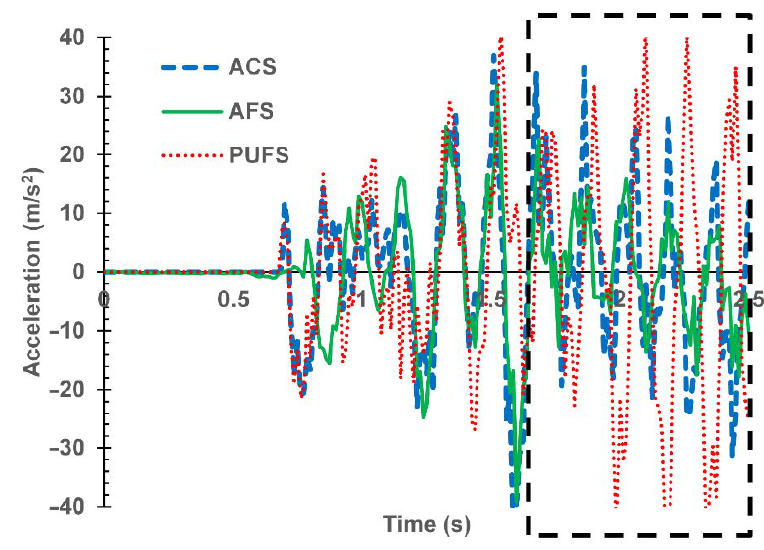
Figure 16. Acceleration–time curves at the nacelle of the OWT.